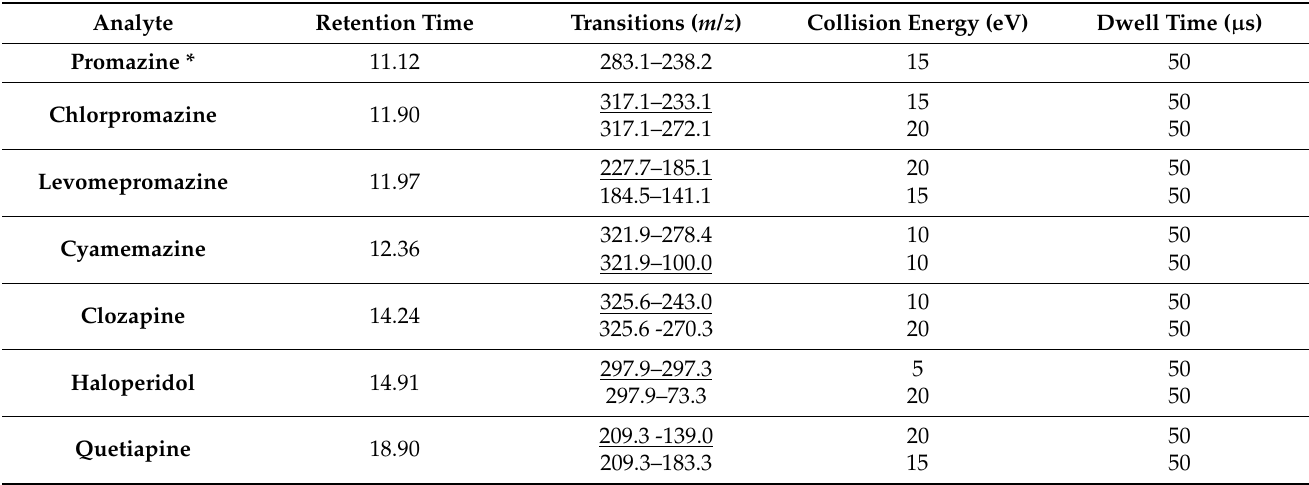
Table 4. Retention times, selected transitions, collision energies, and dwell times for the identification of each analyte under